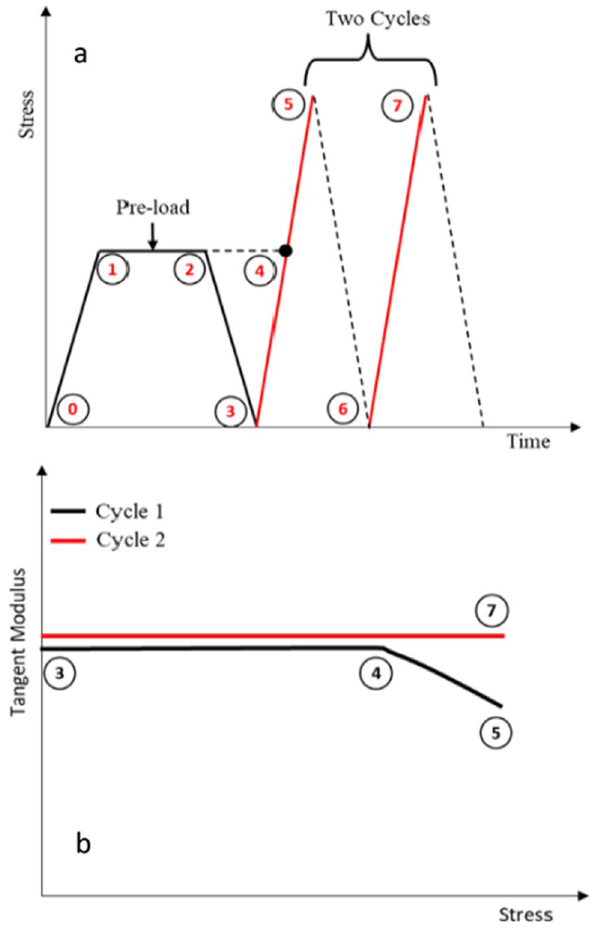
Fig. 4 Schematic of the TMM showing a Preloading (0–3) and load- ing cycles (3–7) b Bending points in the TMM curve at applied stress level (4) in the first loading cycle